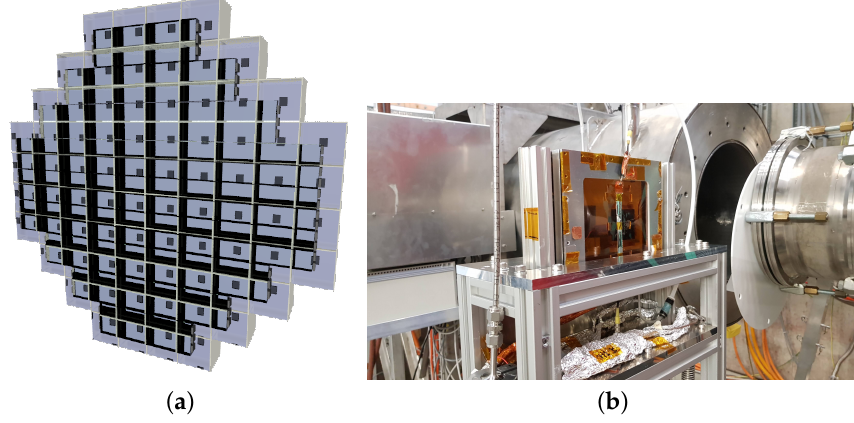
Figure 5. ( a ) The downstream RDC. ( b ) Proto-type RPC tested with the µ